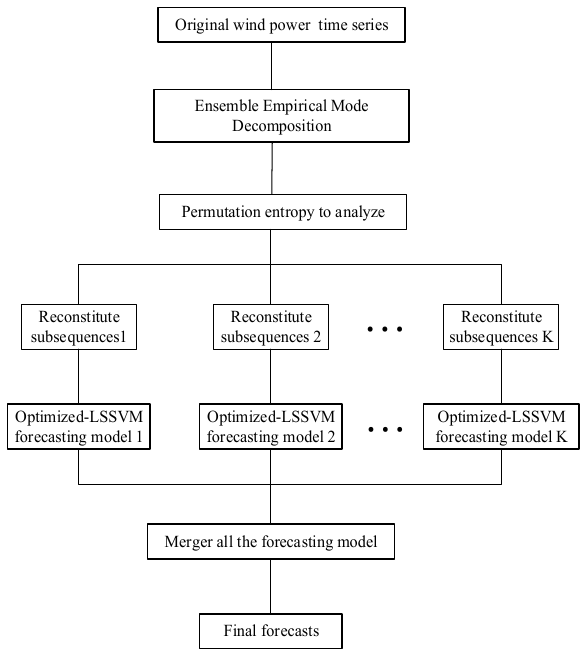
Figure 2. The procedure of the new proposed prediction model.